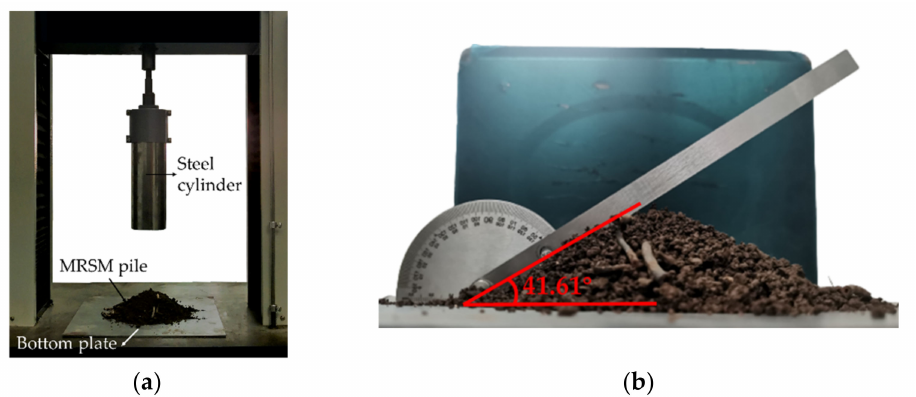
Figure 9. Measurement of physical AOR of MRSM. ( a ) Test device; and ( b ) AOR value.